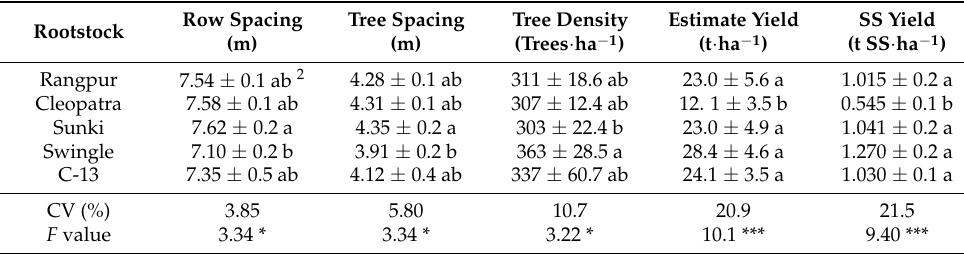
Table 5. Estimates 1 of minimum row and tree spacing, maximum tree density, fruit yield, and soluble solids (SS) yield for new plantings of ‘Shamouti’ sweet orange trees grafted on different rootstocks. Means were based on the scion–rootstock performance under the humid subtropical climate, in the north of the state of Paran á , Brazil, from 2005 to